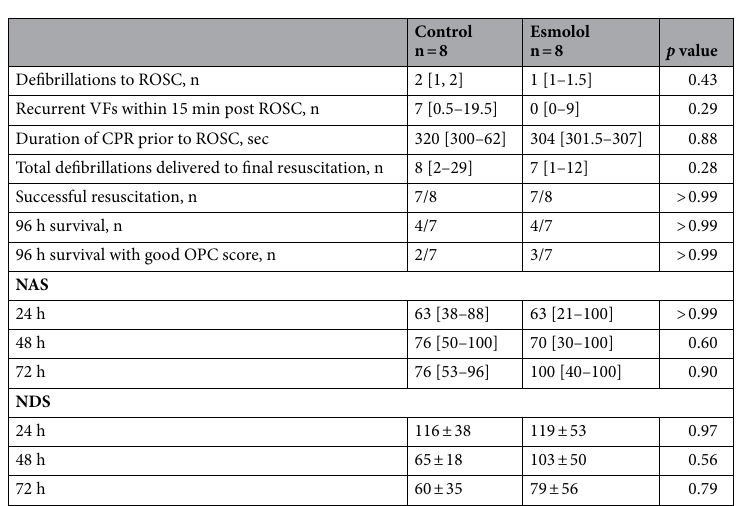
Table 2. Resuscitation outcome. Data are expressed as median and interquartile range or mean ± SEM. ROSC, return to spontaneous circulation; CPR, cardiopulmonary resuscitation; OPC, Overall performance category (OPC was defined good when = 1–2); NAS, Neurological Alertness Score; NDS, Neuronal Deficit Score.